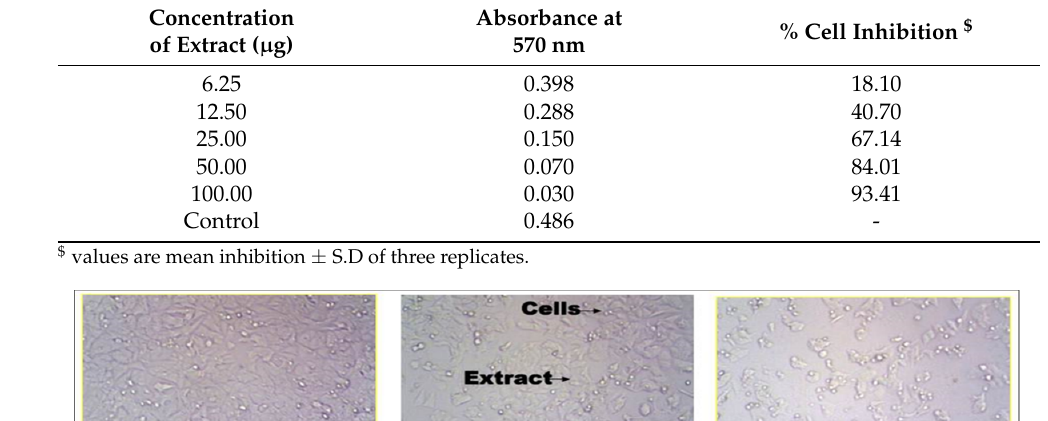
Table 8. Anticancer activity of Simarouba glauca extract.